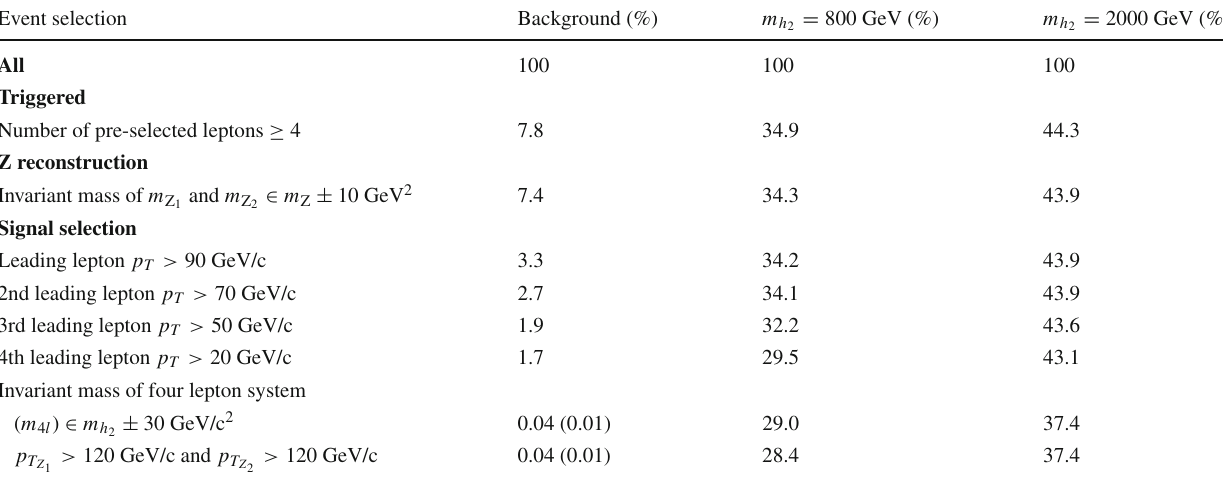
Table 4 Effects of various selection cuts for the analysis of signal and background events at 100 TeV. The values for the background are given for = 800 GeV by default while the values in parenthesis indicate the remaining percentage of events for m m h 2